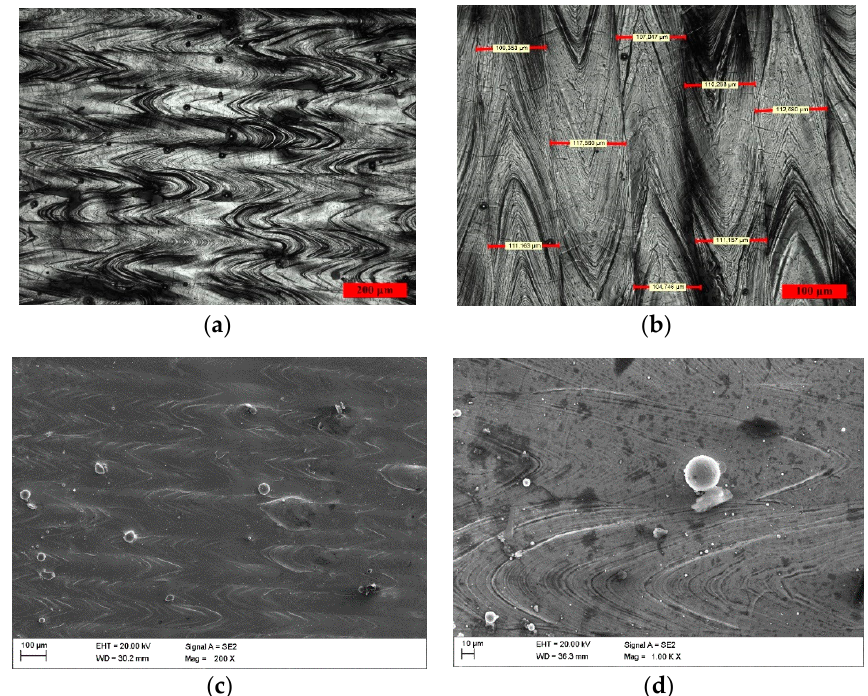
Figure 17. The surface structure of Ti6Al4V Ti solid 4 alloy specimen made ( a , b ) on a light microscope and ( c , d ) on an SEM.